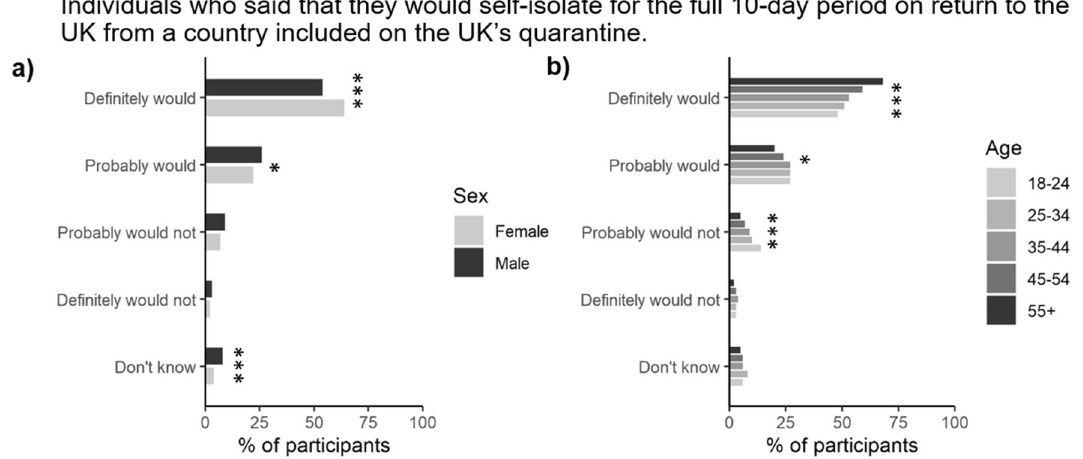
Figure 6. Proportion of participants stratified by either ( a ) gender, or ( b ) age ( n = 2103). *, **, and *** represent significant differences between the gender or age categories for a particular symptom at the P < 0.05, P < 0.01 or P < 0.001 level,